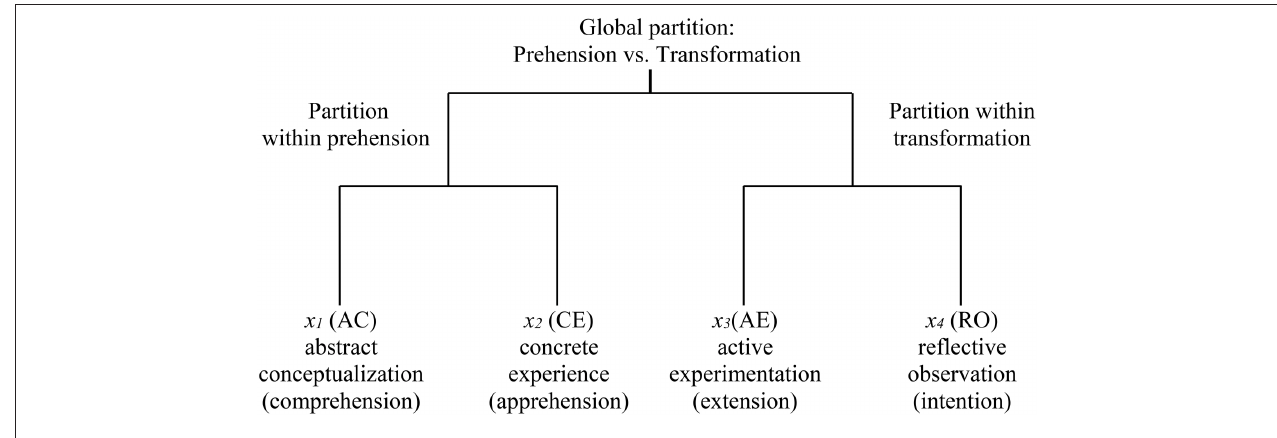
FIGURE 2 | Sequential partition of modes in the